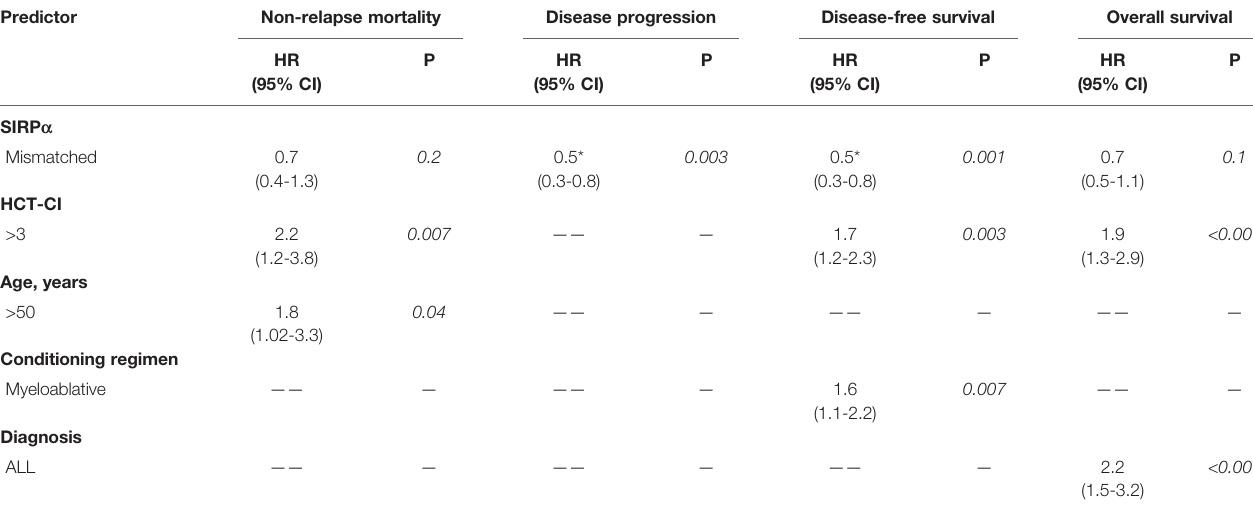
TABLE 5 | Multivariate analysis evaluating predictors of non-relapse mortality, disease progression, progression-free survival and overall survival. Predictor